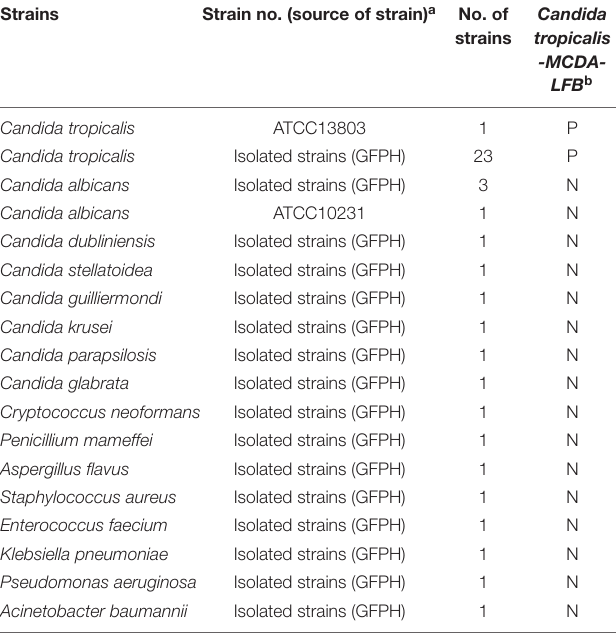
TABLE 1 | Fungi and bacteria strains used in the current study.